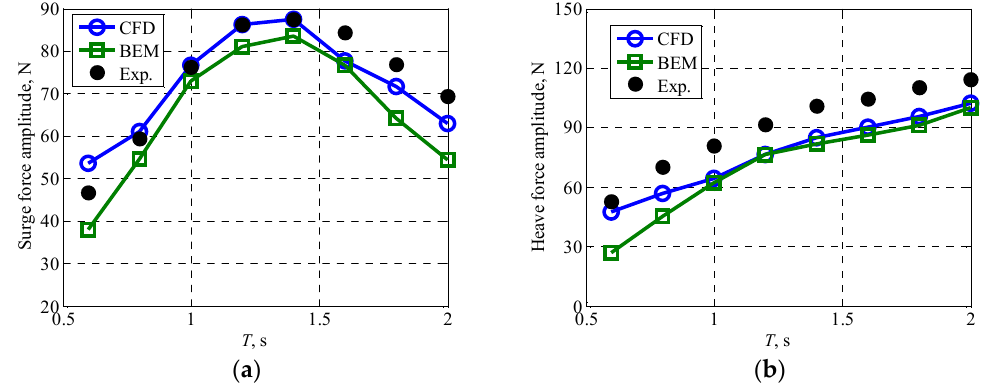
Figure 11. Comparison of the hydrodynamic force amplitude as a function of wave period at H = 0.075 m: ( a ) surge force; ( b ) heave force.